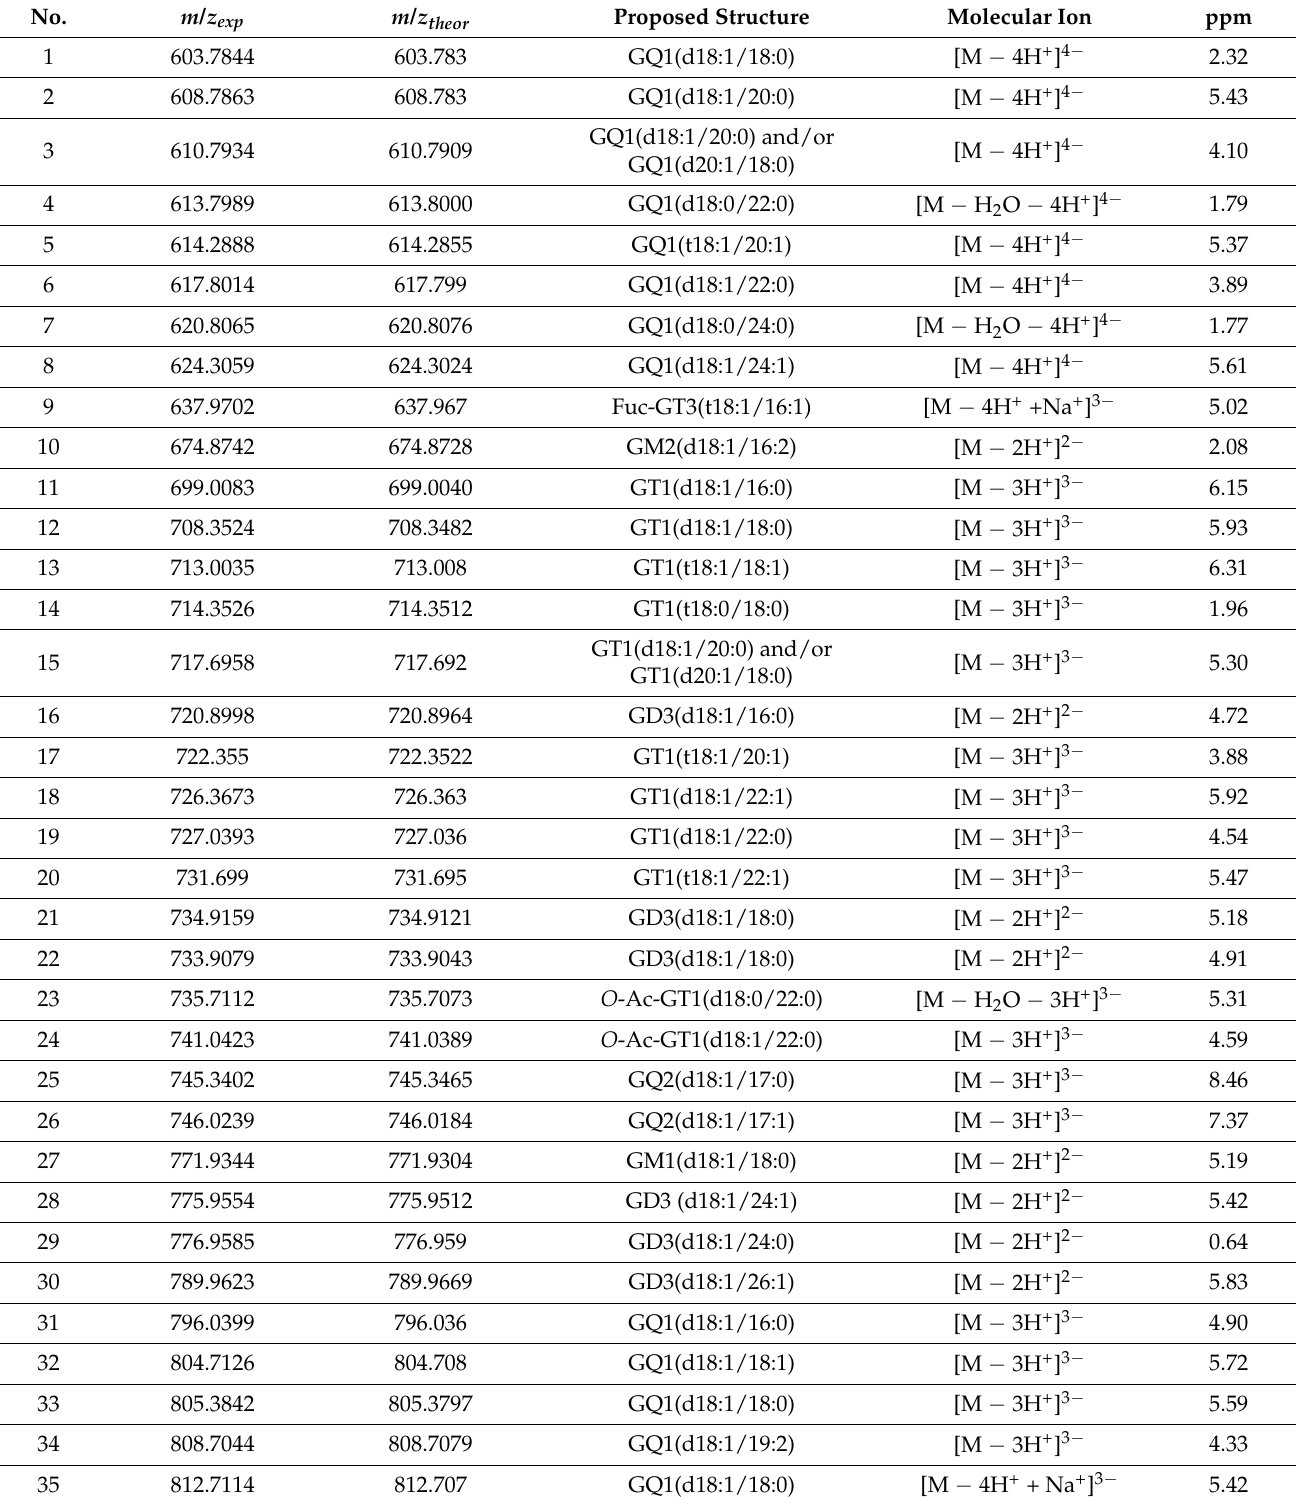
Table 1. The assignment of the ions detected in the spectrum in Figure 2 and the